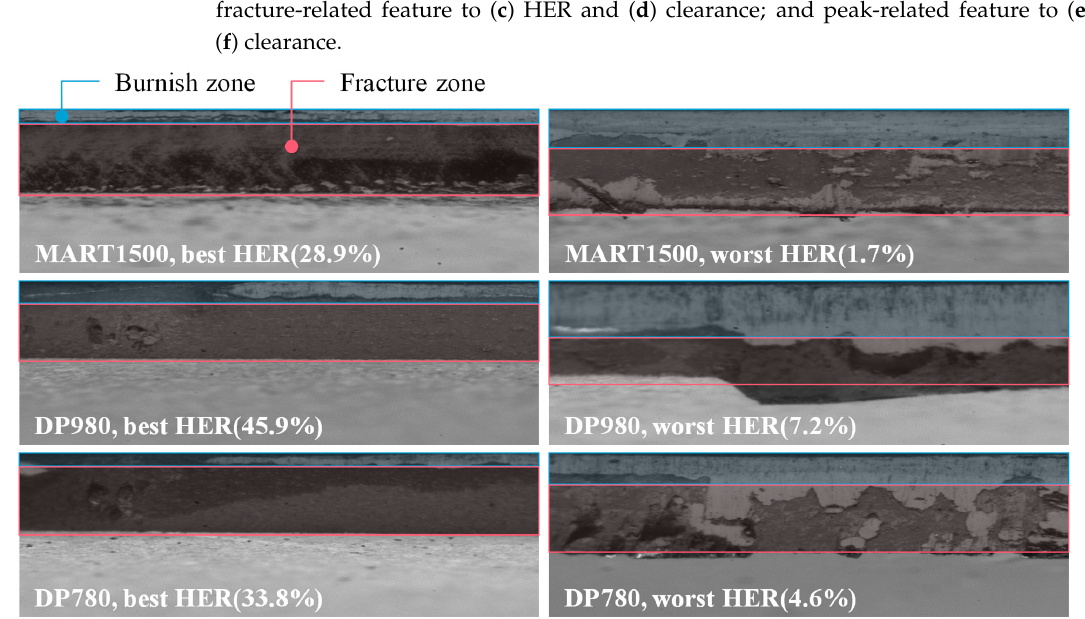
Figure 18. Edge image for all three materials with the highest HER and the lowest HER.